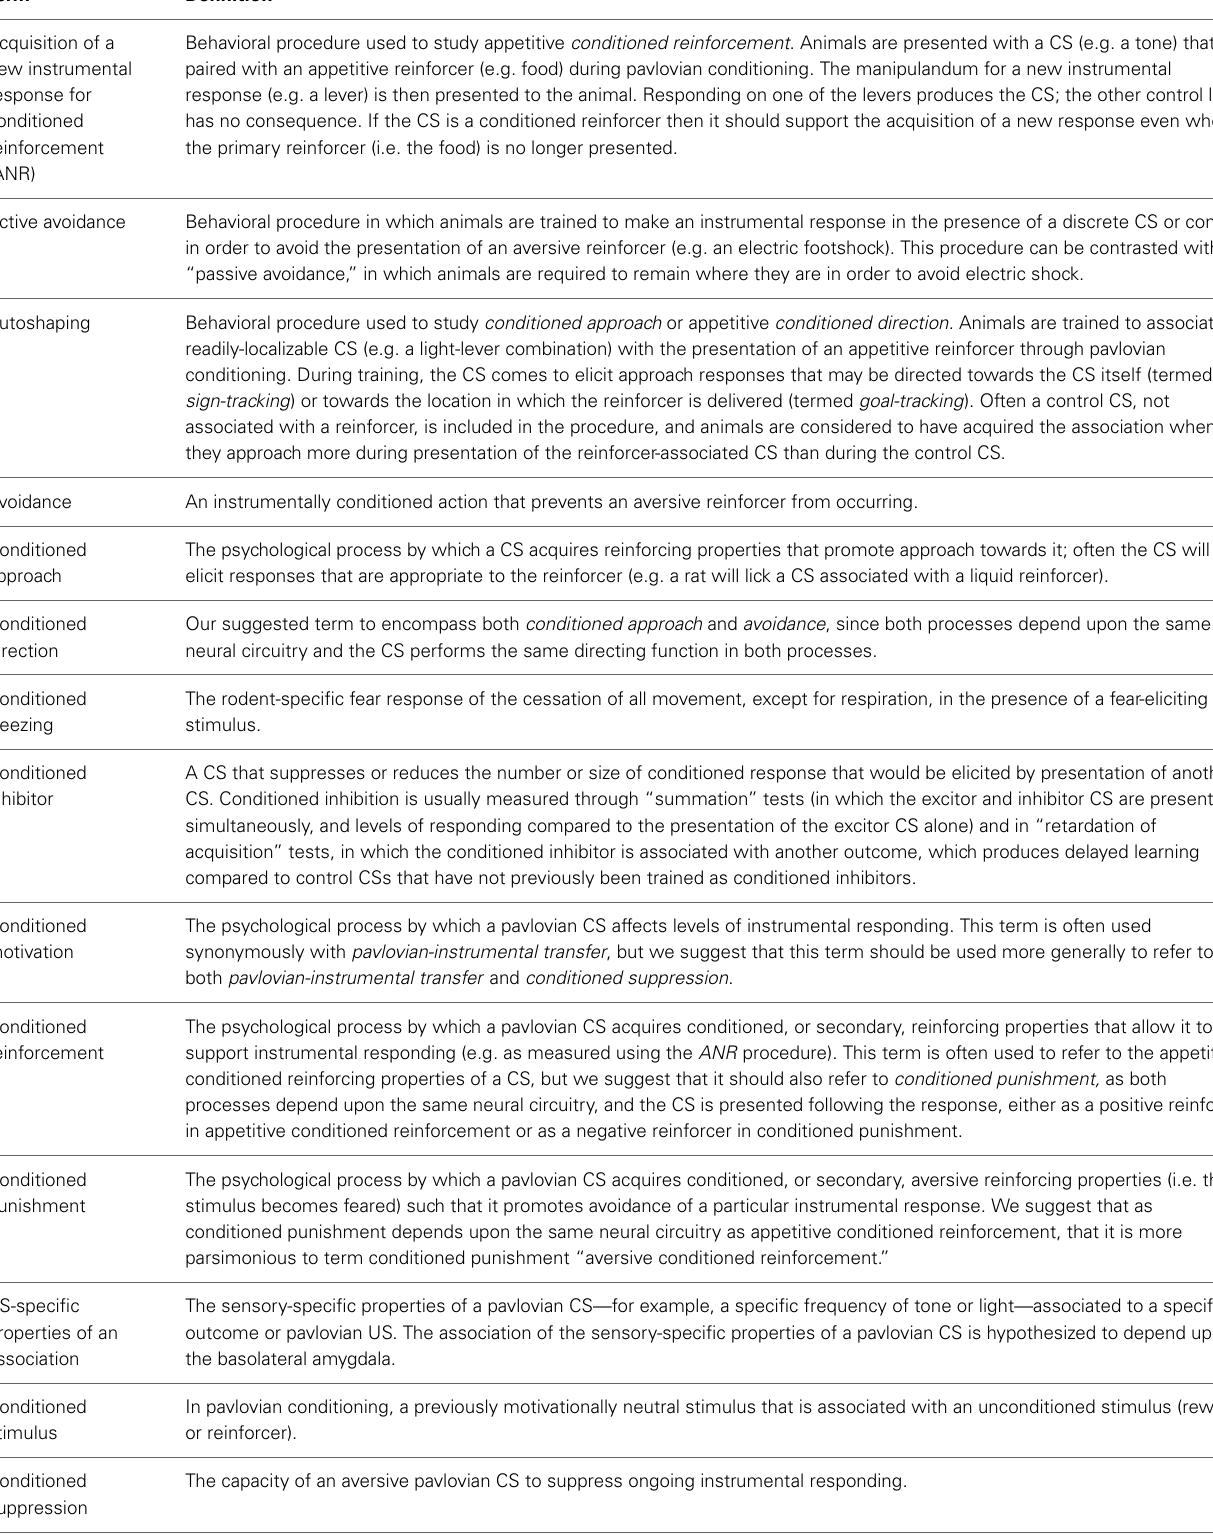
Table 1 | Definitions of specialized psychological and behavioral